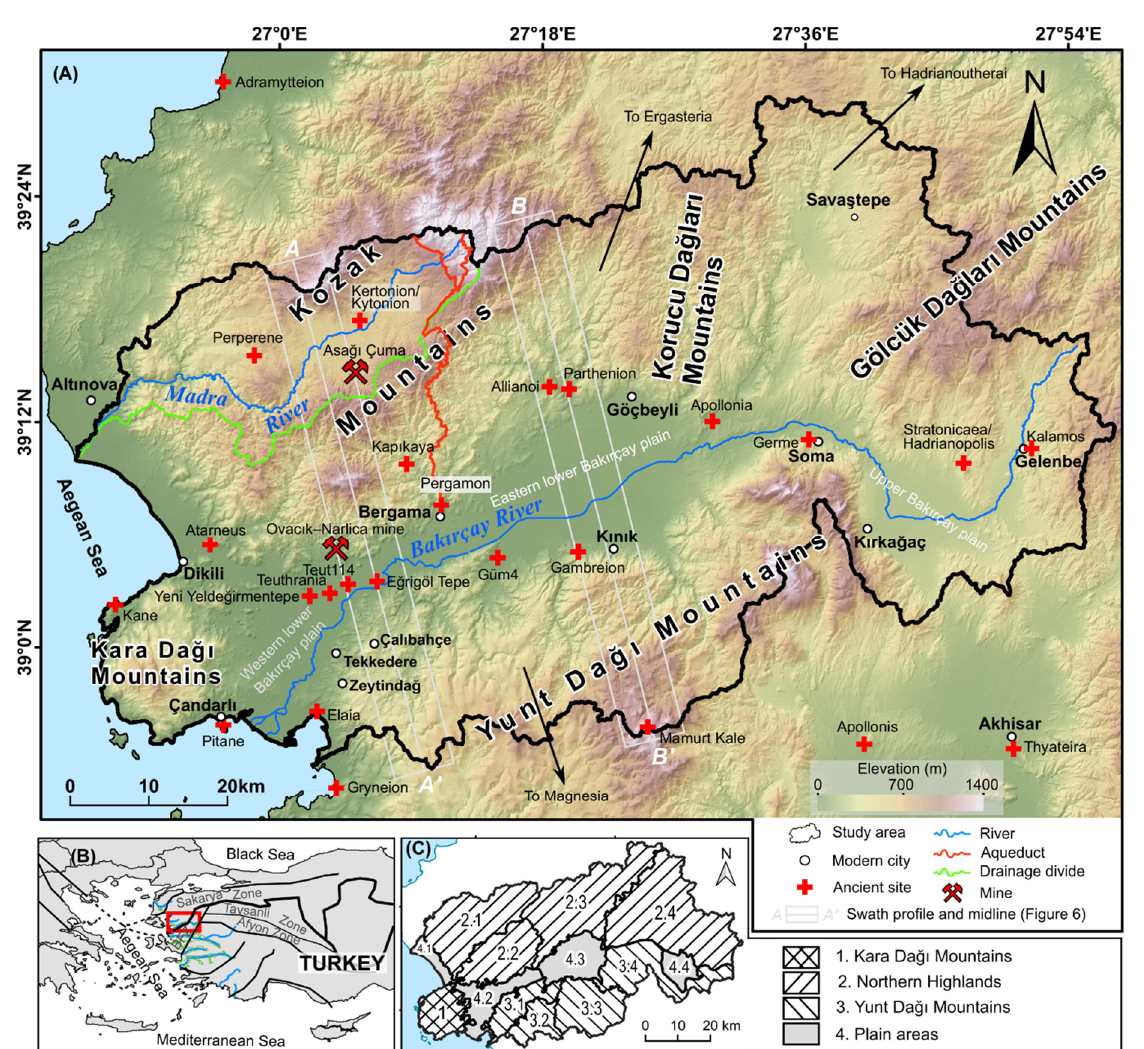
Figure 1. ( A ) Overview map of the Pergamon Micro-Region (Bakırçay and Madra River catchments and the adjacent coastal areas). Data: (1) ancient site [9–11,17–19]; (2) aqueduct: The Atlas Project of Roman Aqueducts (https://www.romaq.org/the-project/aqueducts/article/692#tab-details, last accessed 8 June 2021) [20] (p. 150); (3) mine site [21,22]; (4) elevation data: TanDEM-X digital elevation model (12-m horizontal resolution) [23,24]. ( B ) The location of the study area (red rectangle), highlighted with the major westward-trending rivers (blue lines) and their alluvial plains (green polygons) along the Aegean coastal region of west Turkey (modified from [1]), and the major tectonic structures (shown as black thin lines in the west of Anatolia and dashed lines linked to the sutures across the Aegean Sea) and tectonic zones (black thick line: the İzmir–Ankara Suture Zone; BFZ: Bornova Flysch Zone) modified from [25]). ( C ) Geomorphological units and subunits of the Pergamon Micro-Region.